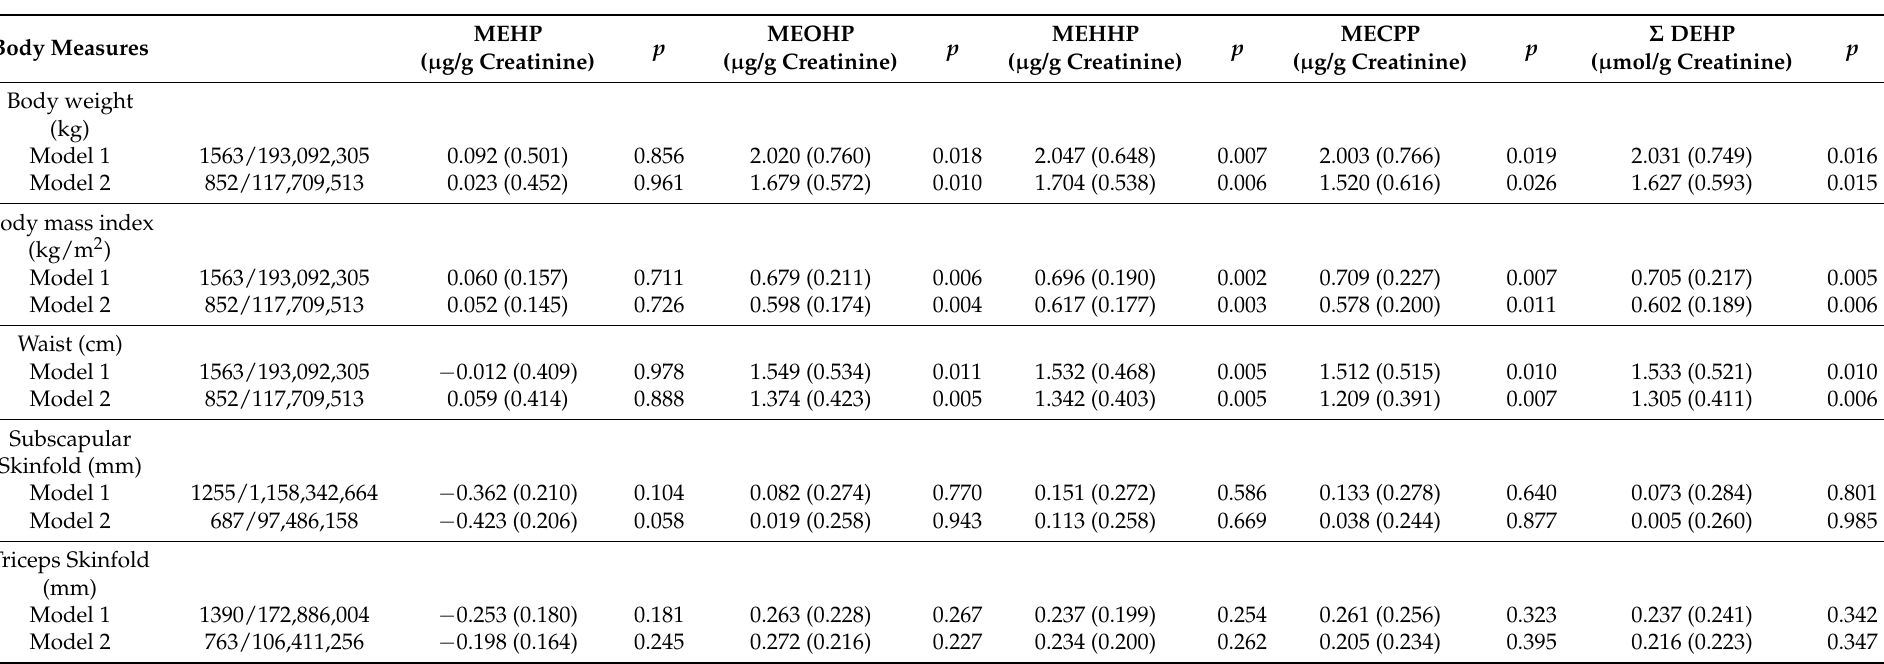
Table 3. Linear regression coefficients (S.E.) of body measures with a one-unit increase in ln-DEHP metabolite concentrations in adults, with results weighted for sampling